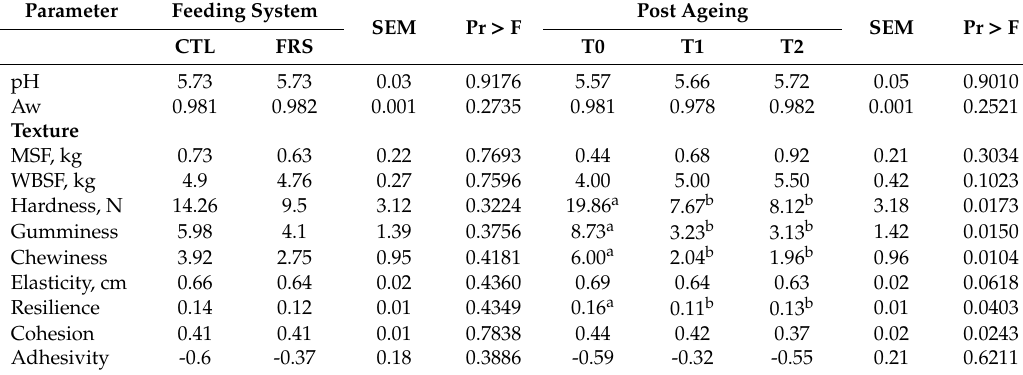
Table 3. E ff ect of feeding system and post dry ageing on meat quality of bu ff aloes fed with (FRS; n = 8) or without (CTL; n = 8) ray grass in Longissimus muscle.